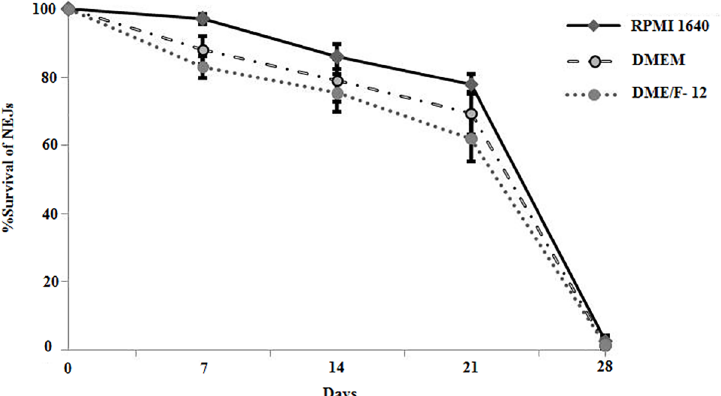
Fig 1. Survival of F . gigantica NEJs in RPMI-1640, DMEM and DME/F-12 culture media supplemented with 10% foetal bovine serum, 2% glucose and 25 mM HEPES. NEJs showedhigher% survival ( (cid:21) 80%) in RPMI-1640which was lower in DMEM and DME/F-12 medium ( (cid:21) 75%and (cid:21) 72%), respectivelyat 3 weeks of culture. All flukes died by 28–30 days of